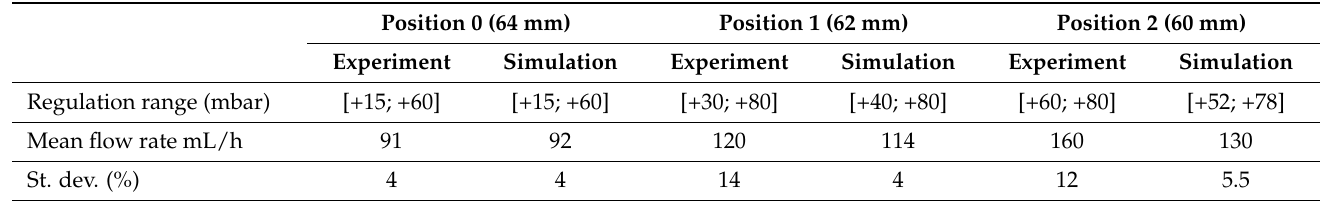
Table 1. Regulation range and mean flow rate of the device at the three different